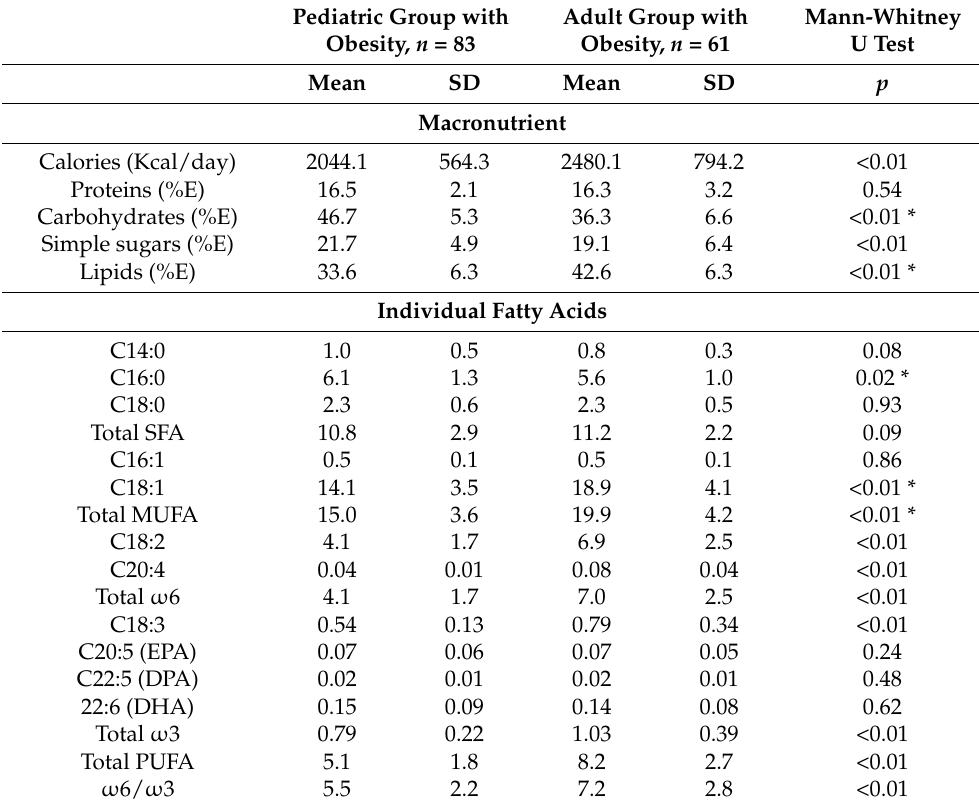
Table 3. Macronutrients and individual fatty acids (FA) intake expressed as % energy (% E ) in pediatric and adult groups with